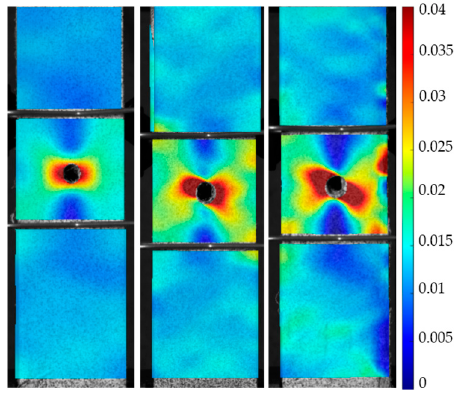
Figure 10. Longitudinal Eulerian strain concentrations for a selected control, 144 ‐ h, and 288 ‐ h composite sample at a global strain of 1.5%.